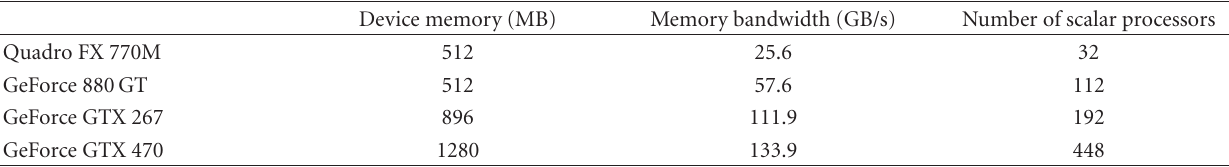
Table 2: Specifications of the GPUs in the benchmark test of Section 5.3. Source: http://www.nvidia.com/content/global/global.php.